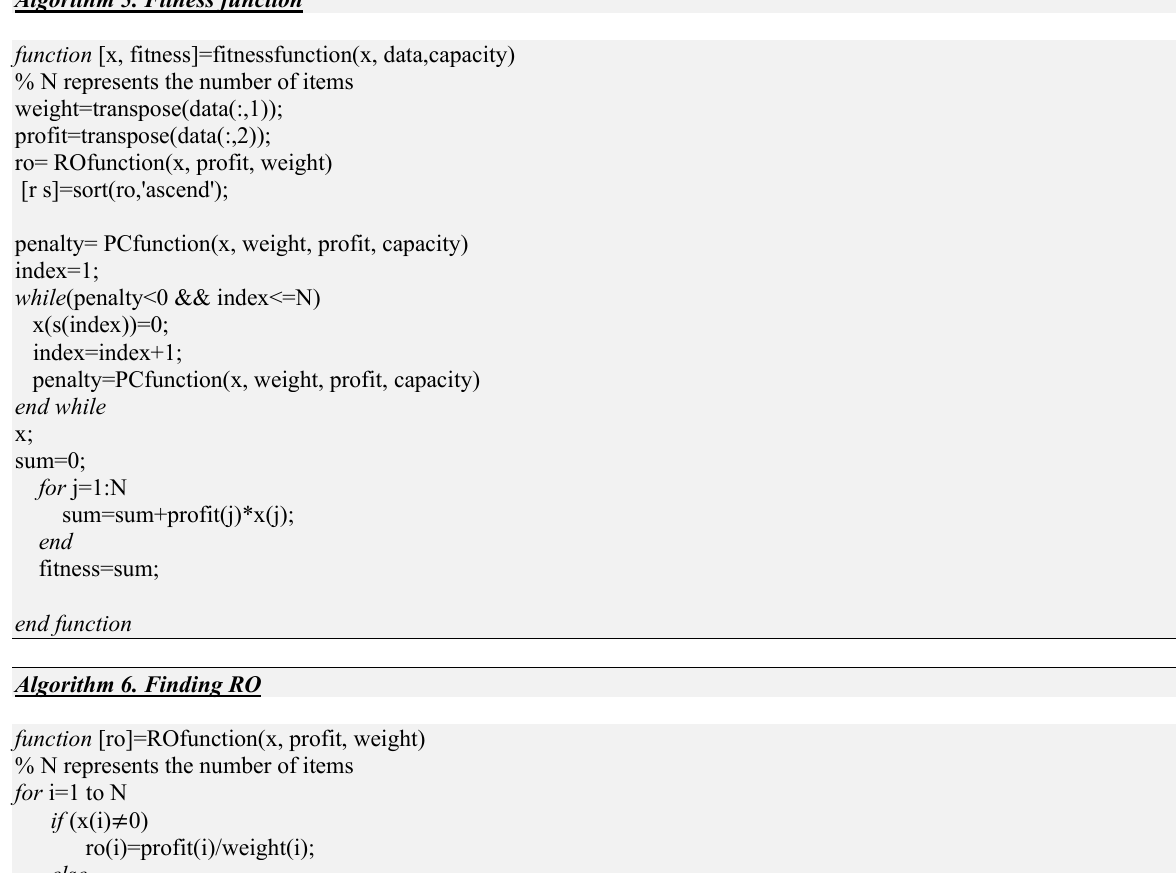
Algorithm 5. Fitness function